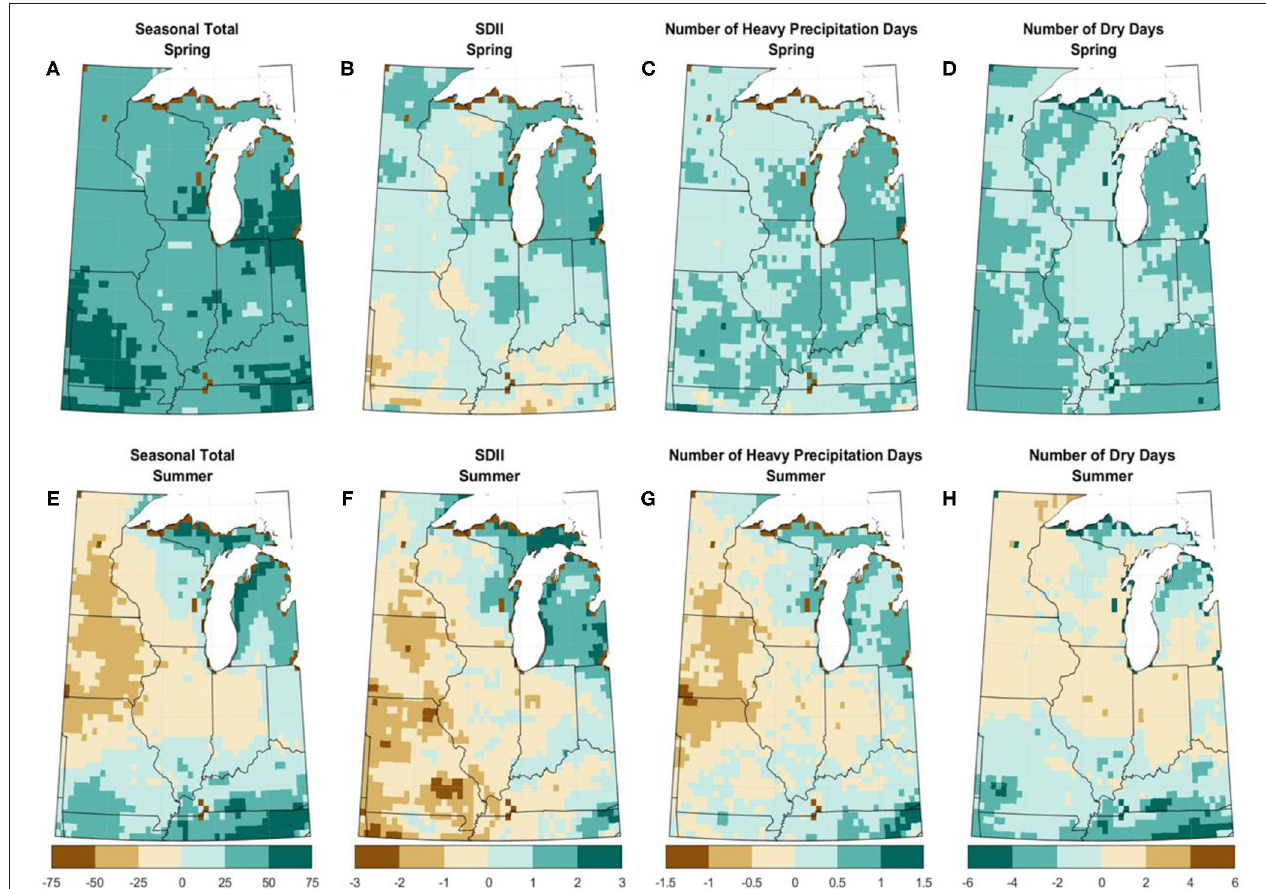
FIGURE 2 | The NA-CORDEX multi-model ensemble median error when compared with the upscaled NClimDiv observed climatology for the spring and summer over the historical period 1951–2005. Shown are the results for the seasonal precipitation totals [ (A,E) , mm], SDII [ (B,F) , mm day − 1 ], seasonal number of days with heavy precipitation [ (C,G) , days], and seasonal number of dry days [ (D,H) , days].